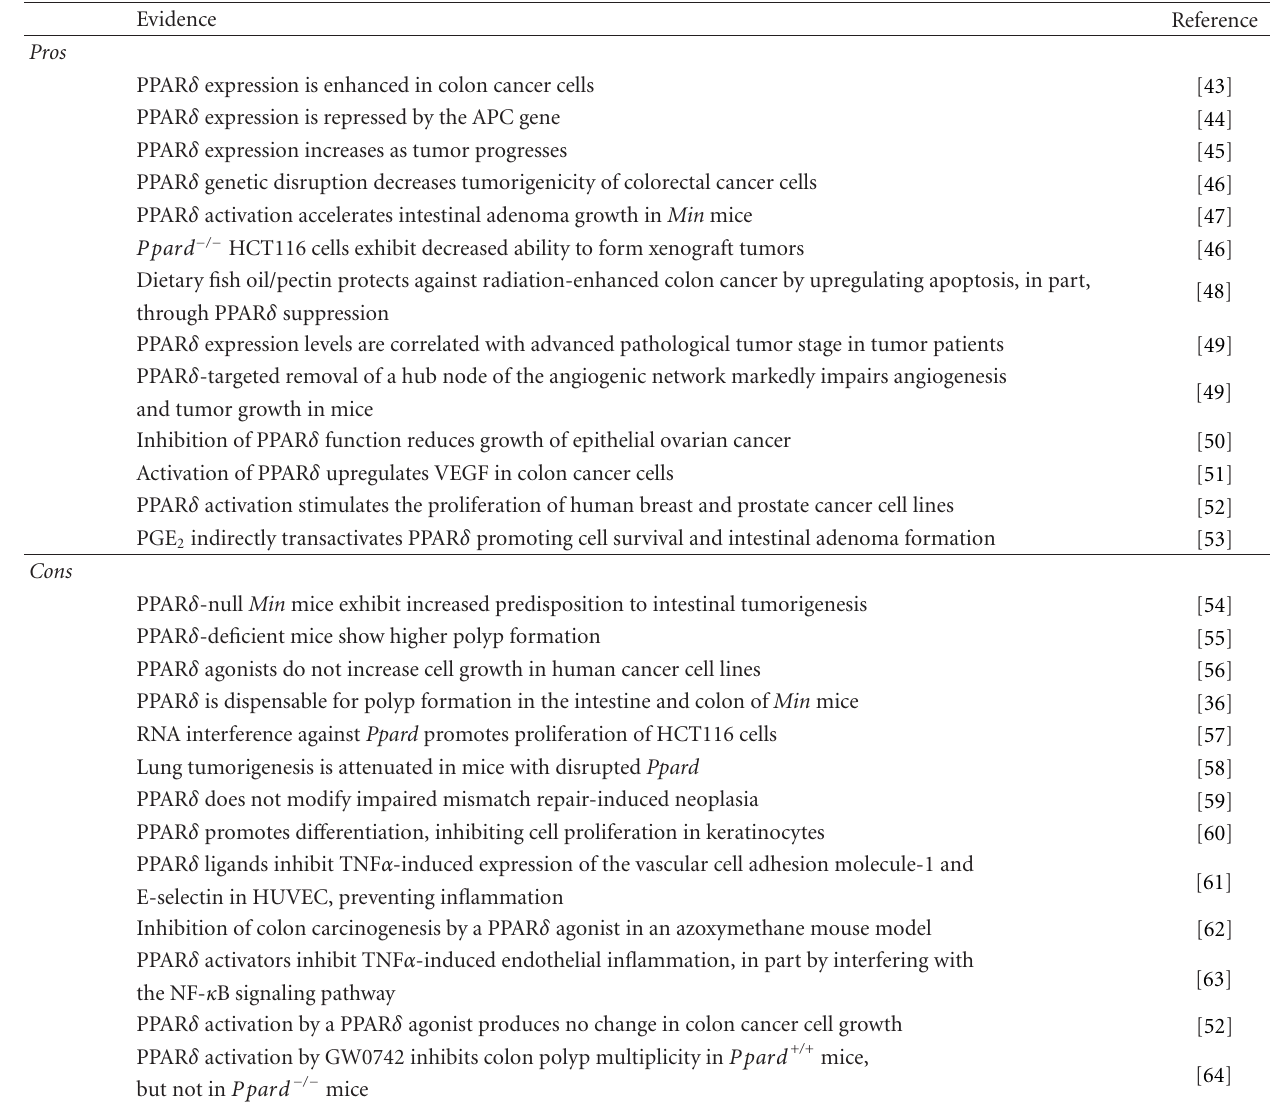
Table 1: The pros and cons for a role of PPAR δ in